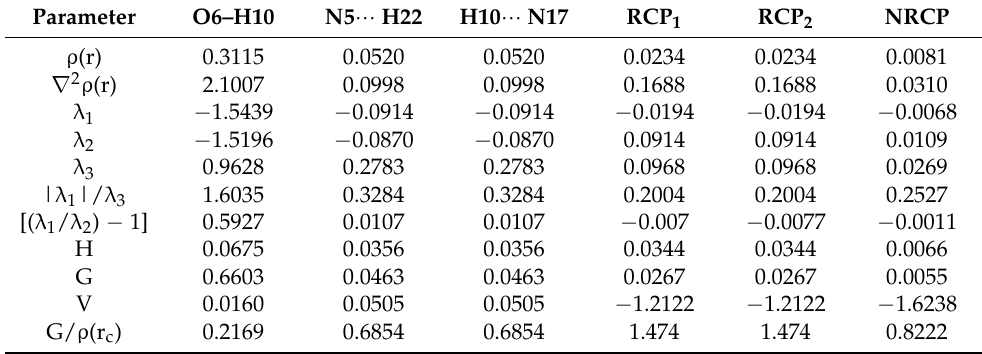
Figure 4. Molecular graphic for 3-Br-2-HyP dimer. Table 2. AIM parameters of the BCP and RCP for both cyclic dimers of 3-Br-2-HyP.